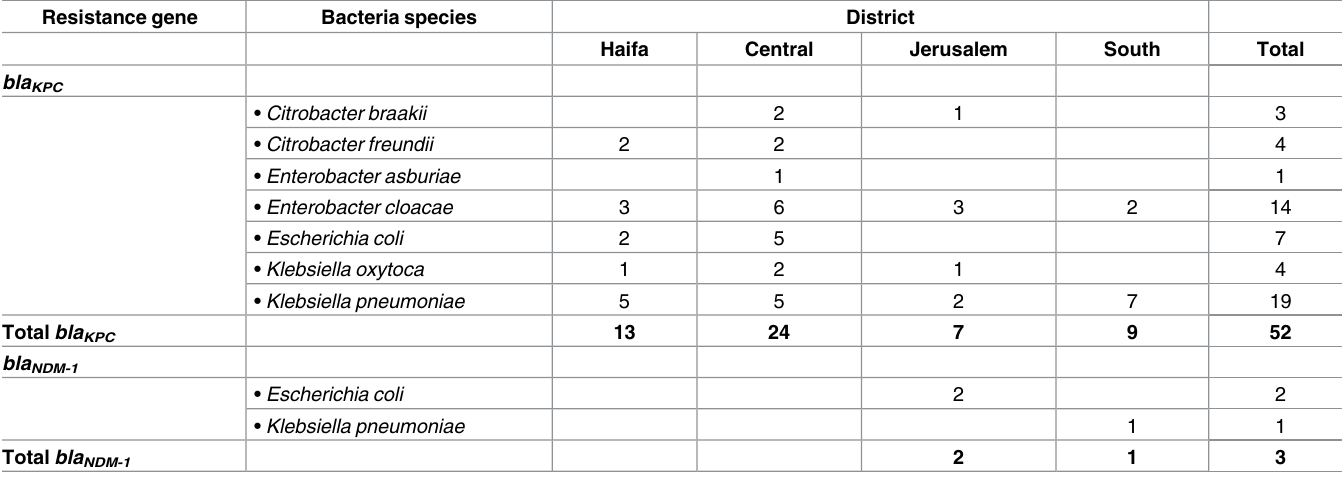
Table 3. The number of bacterial isolates carrying the resistancegenes bla KPC and bla NDM-1 found in different districts in Israel. Resistance